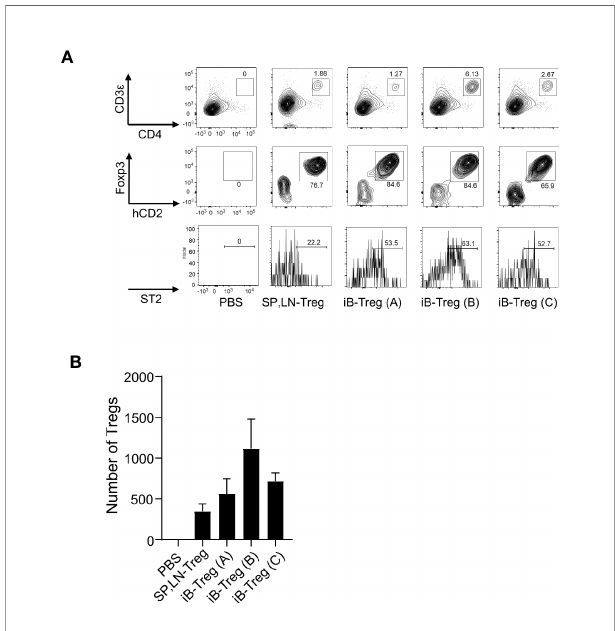
FIGURE 4 | In fi ltration of iB-Tregs into the injured brain. CD3-de fi cient mice with ischemic brain injury were generated using the MCAO model, as described. Splenic and lymph node Tregs (SP, LN-Treg) or iB-Tregs (A – C) after 6 days of co-culture (5 × 10 5 cells/mice N=3-4) were transferred into the CD3-de fi cient mice on day 5 after stroke onset. Seven days later, ST2 expression (A) and cell number (B) of Foxp3 + Tregs in the brain were analyzed using FACS. Data are presented as the average of three independent